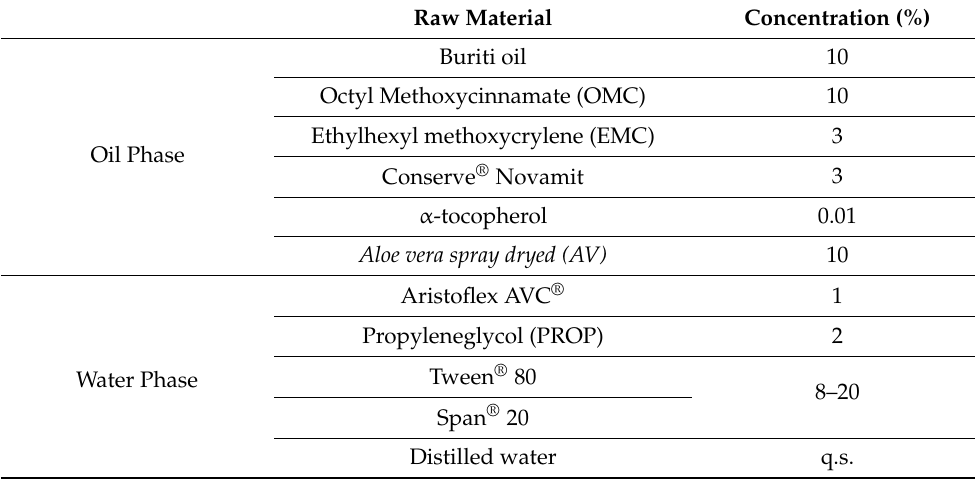
Table 1. General composition of the developed NEs.